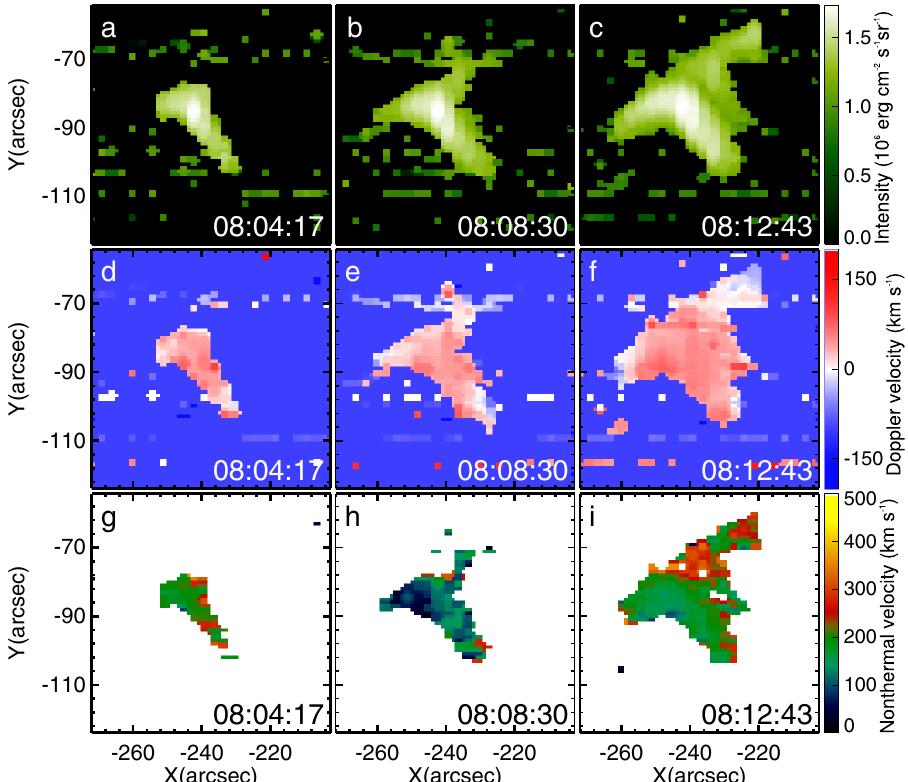
Fig. 4 Hinode/EIS spectroscopic observation at Fe XVII 255 Å during magnetic reconnection. a – c Evolution of the cusp-shaped structure in the intensity images. d – f Doppler velocity and g – i non-thermal velocity obtained from single Gaussian fi tting. Source data are provided as a Source Data fi